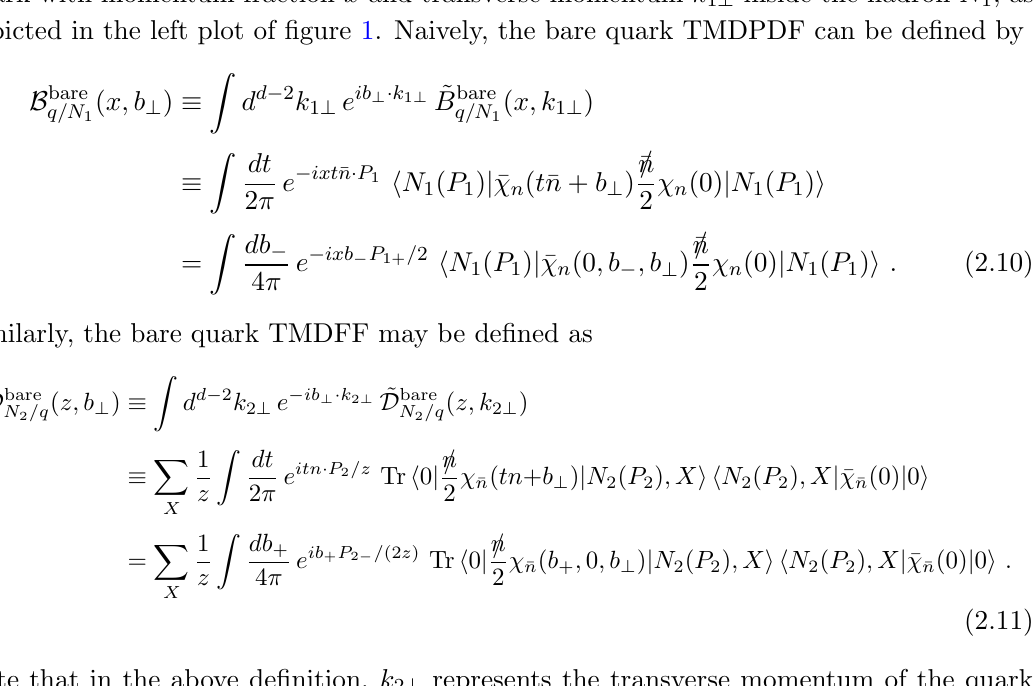
Figure 1 . Kinematics for TMDPDFs (left plot) and for TMDFFs in the parton frame (right plot). The quark TMDPDF ~ B ( x; k ) describes the probability distribution of (cid:12)nd 1 ? ; (cid:22) q=N 1